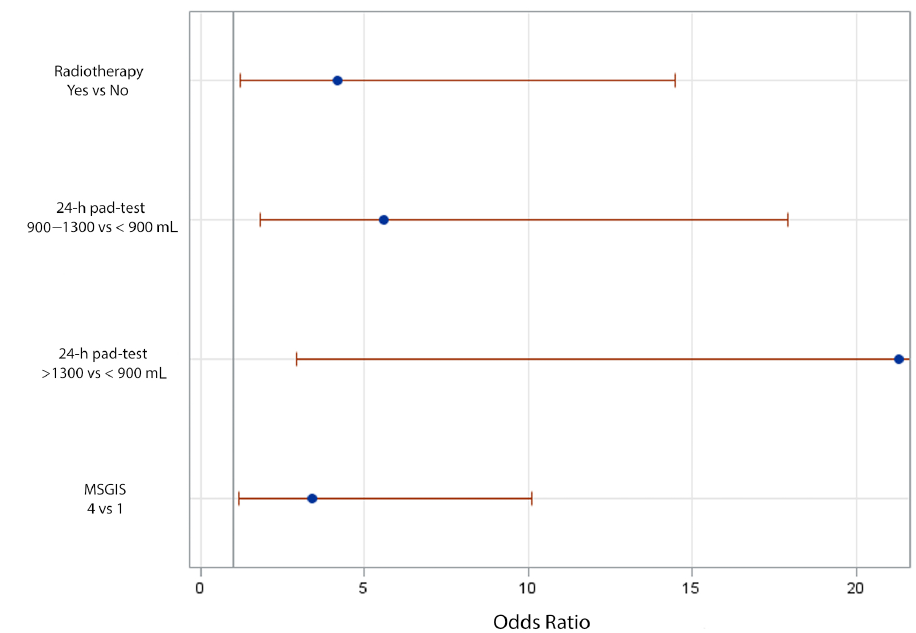
Figure 2. Odds ratios with 95% profile-likelihood confidence limits.